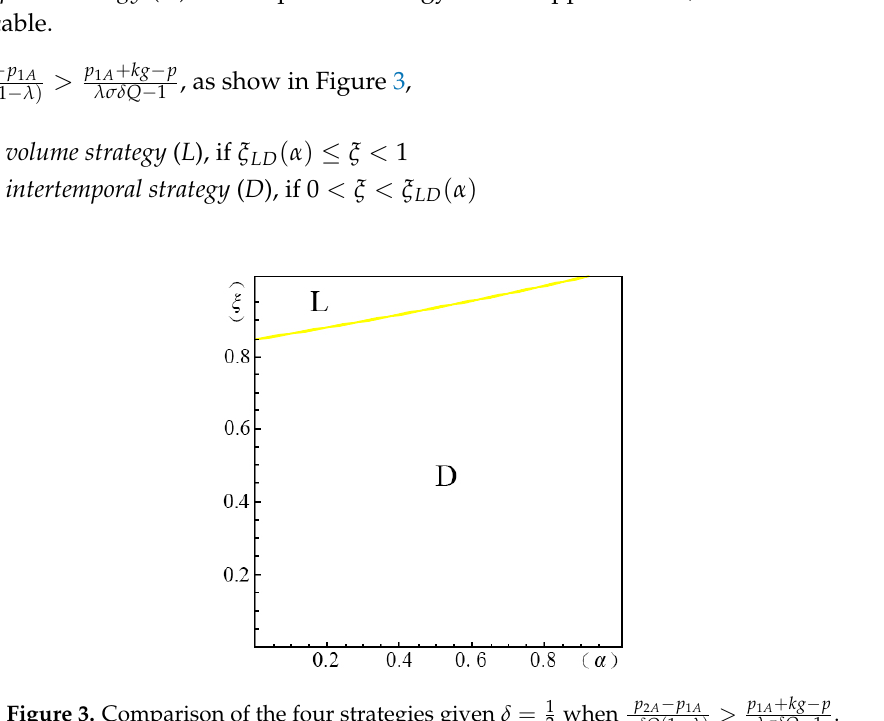
− p 1 A ≤ p 1 A + kg − p (cid:3409) (cid:3043) (cid:3117)(cid:3250) (cid:3397)(cid:1863)(cid:1859) (cid:2879)(cid:3043) . . Figure 2. Comparison of the four strategies given δ = 1 when p 2 A λσδ Q − 1 σδ Q ( 1 − λ ) (cid:3097)(cid:3083)(cid:3018)(cid:4666)(cid:2869)(cid:2879)(cid:3090)(cid:4667) (cid:3090)(cid:3097)(cid:3083)(cid:3018)(cid:2879)(cid:2869)